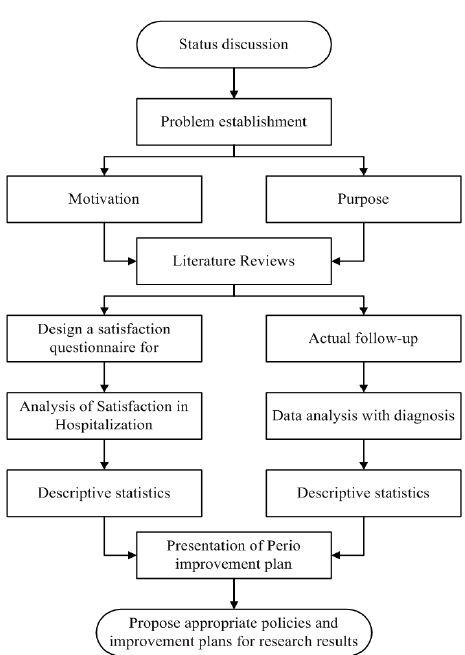
Figure 2. Research